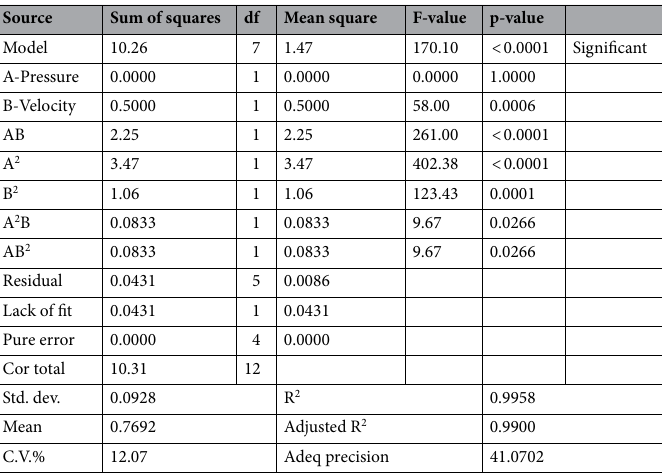
Table 18. ANOVA results for quadratic model (voids zone is response) of hot-rolled steel.